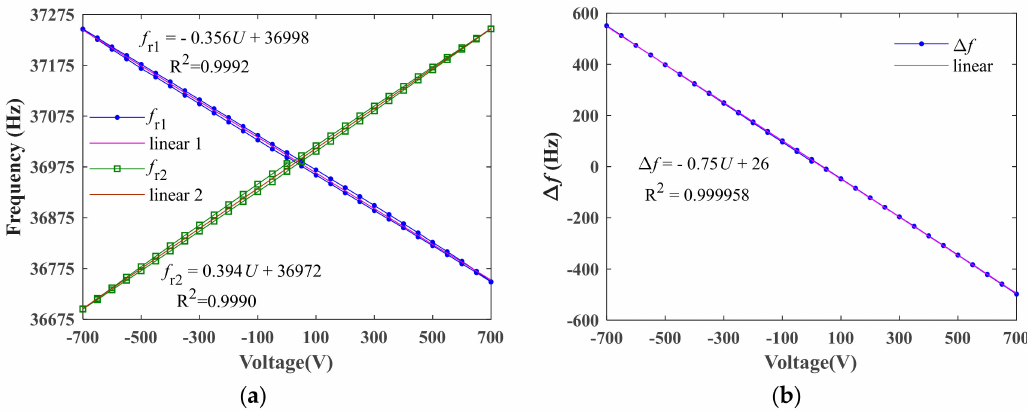
Figure 9. The resonant frequencies of individual DETF 1 and DETF 2 ( a ) and the di ff erential frequency output ( b ) as a function of external DC